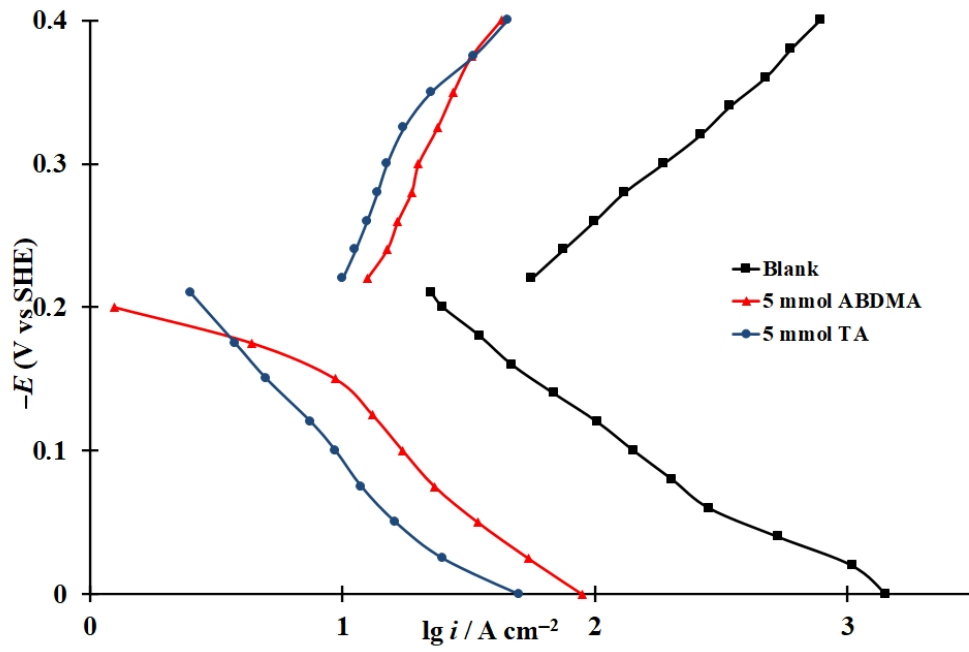
Figure 8. Polarization curves of SS steel at t = 25 °C in 2M HCl in the presence of the following inhibitors ABDMA and TA.